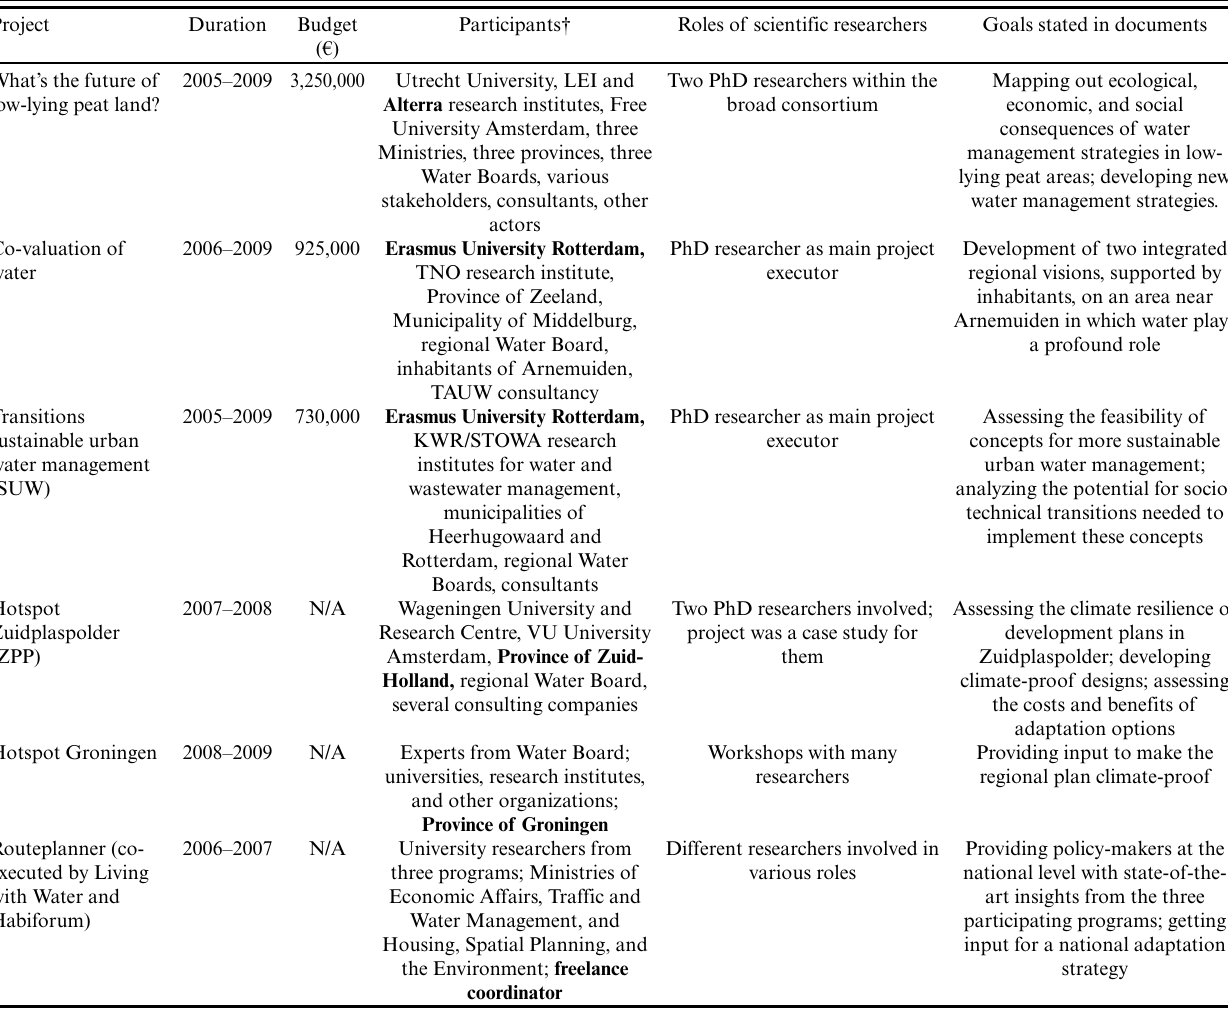
Table 3. Characteristics of the selected projects. Adapted from Hegger et al. (2012 c